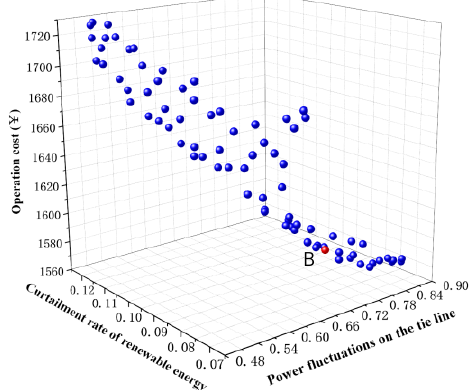
Figure 8. Three-objective non-dominated solution set based on the proposed strategy.